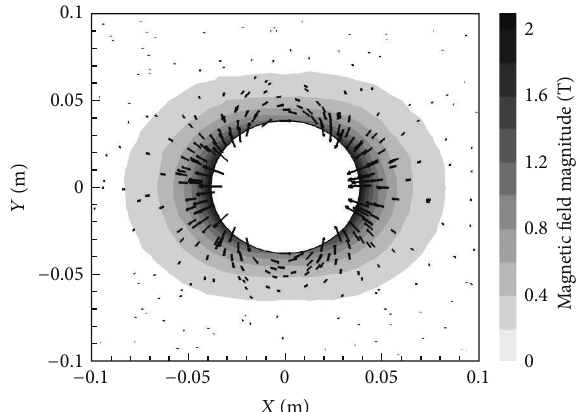
Figure 3: Magnetic field vectors and contours of the magnitude for an 𝑋 -oriented dipole with 𝐵 max = 2